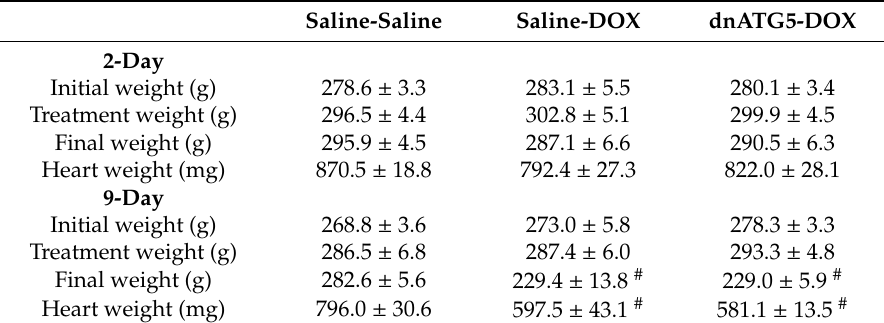
Table 1. Body weight and heart weight among experimental